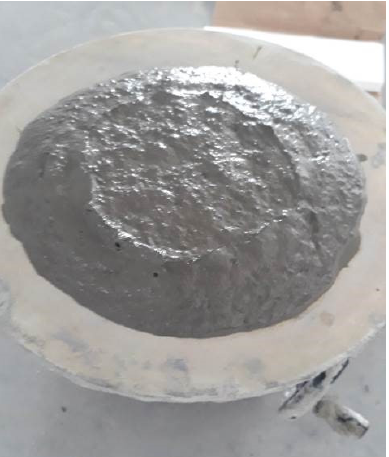
Figure 3. Flow of cement paste containing carbon fiber.